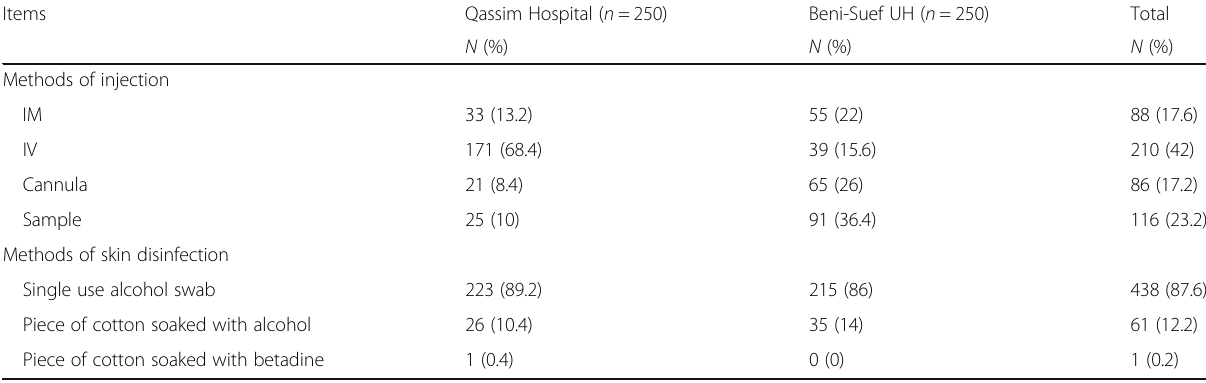
Table 1 Methods of injection and skin disinfection among nurses in Beni-Suef, Egypt, and Maternal and Child Hospital (MCH), Qassim, Saudi Arabia,